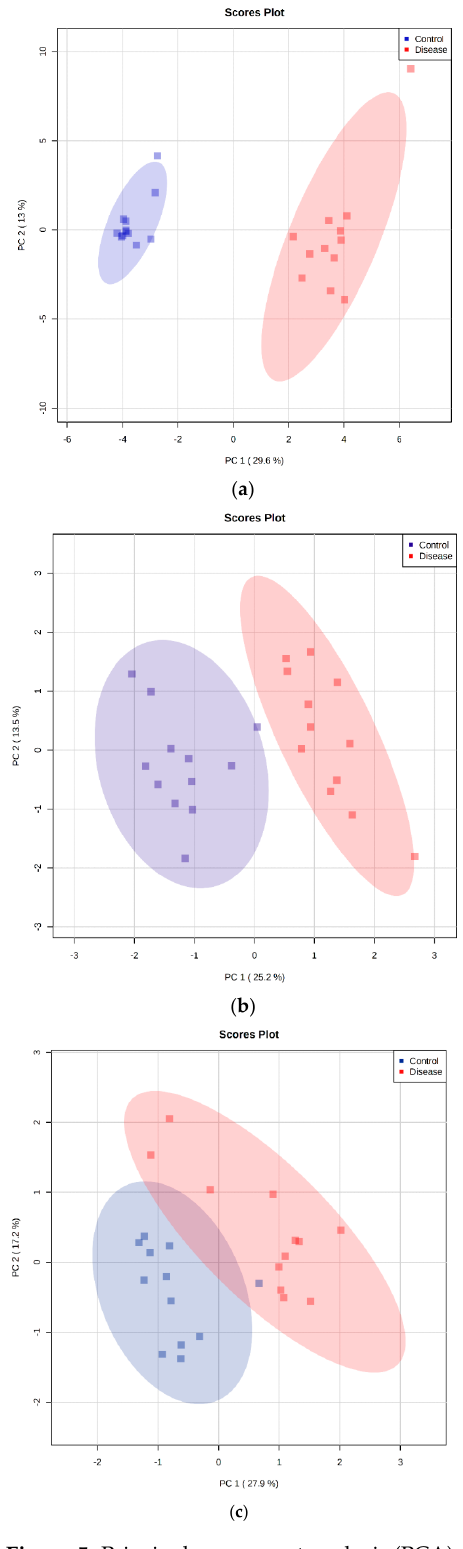
Figure 5. Principal component analysis (PCA) score plots were performed using 24 serum samples of dogs by untargeted LC-MS metabolomics analysis ( a ), targeted LC-MS metabolomics analysis ( b ), and GC-MS metabolomics analysis ( c ). The first two principal components (PCs) explained 426% for the untargeted LC-MS metabolomics, 387% for the targeted LC-MS metabolomics, and 451% of the total variance for the GC-MS